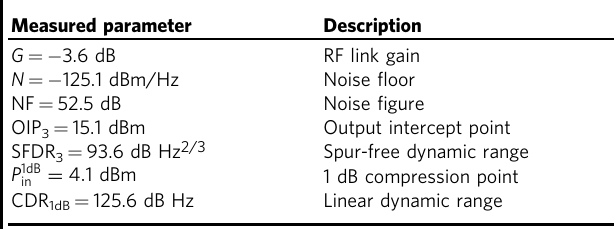
Table 1 Microwave-photonic link parameters, corresponding to the data presented in Fig.